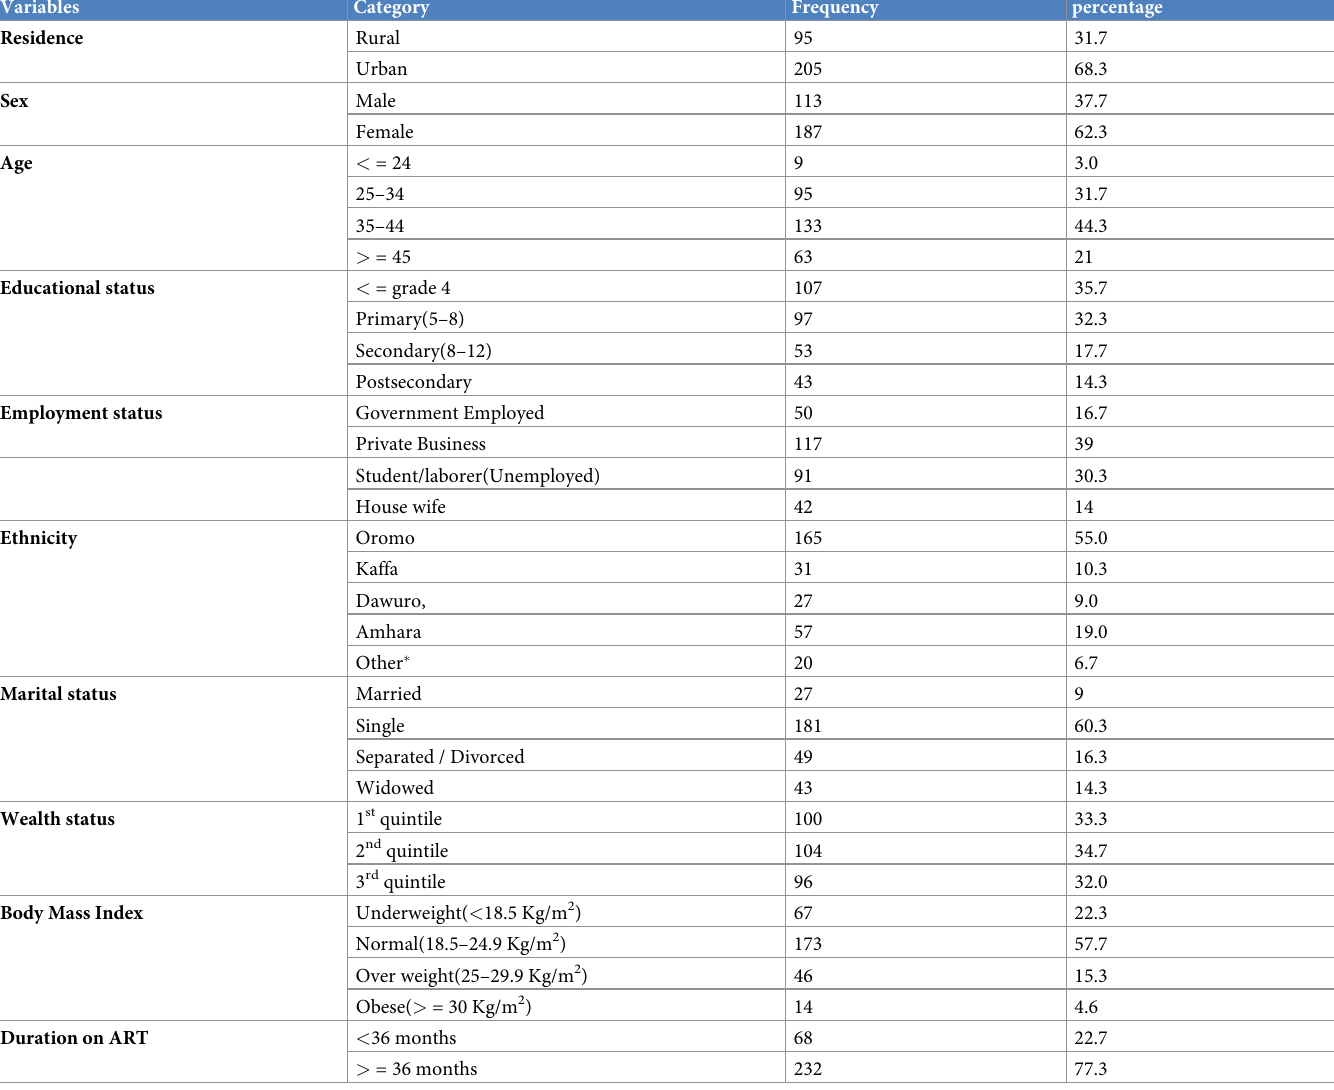
Table 1. Socio-demographic and economic characteristics of quality of life among PLHIV in Jimma zone public hospitals, South-west